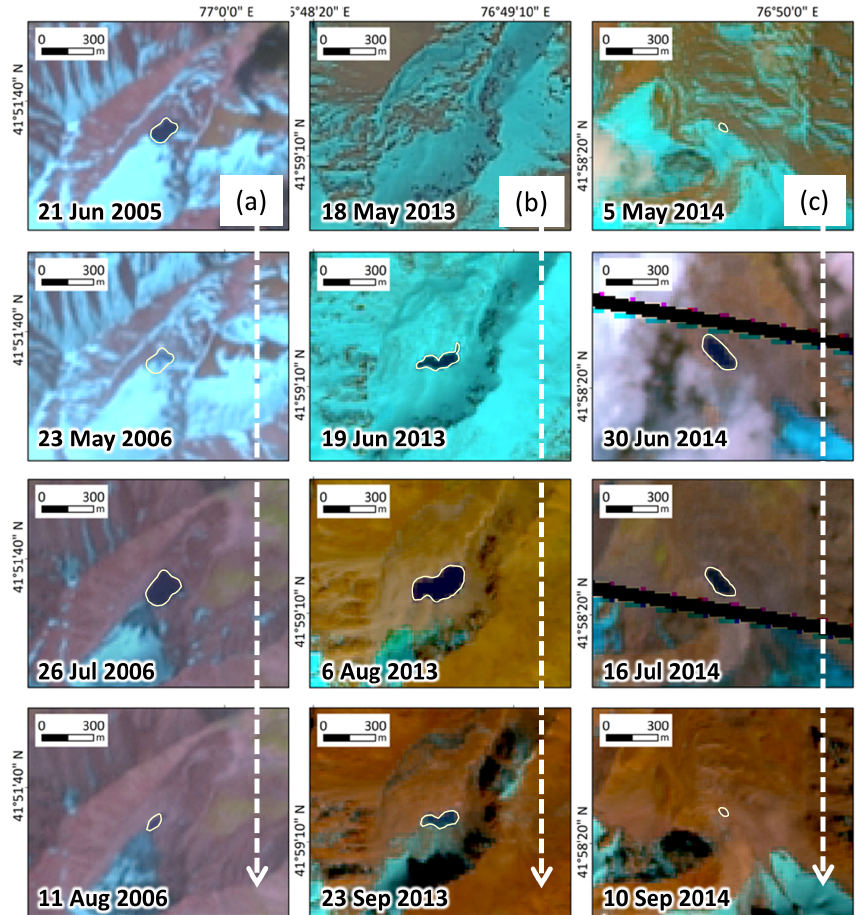
Figure 3. Changes of three lakes. Column (a) is Kashkasuu, (b) is Jeruy, and (c) is Karateke lake. Images are from Landsat7 ETM + and Landsat8 OLI. The locations are in Fig. 1.